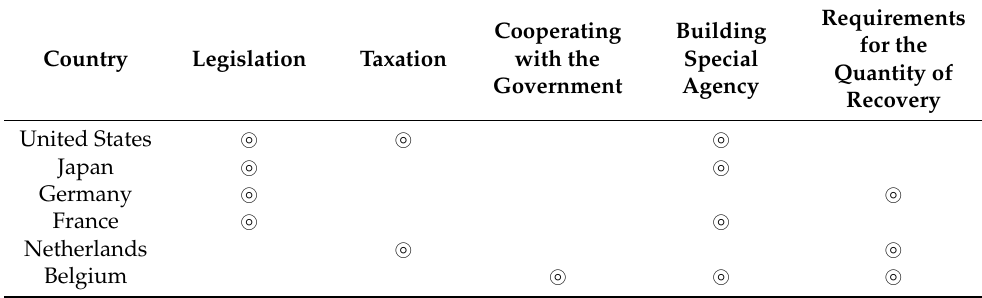
Table 5. Summary of packaging recycling practices in different